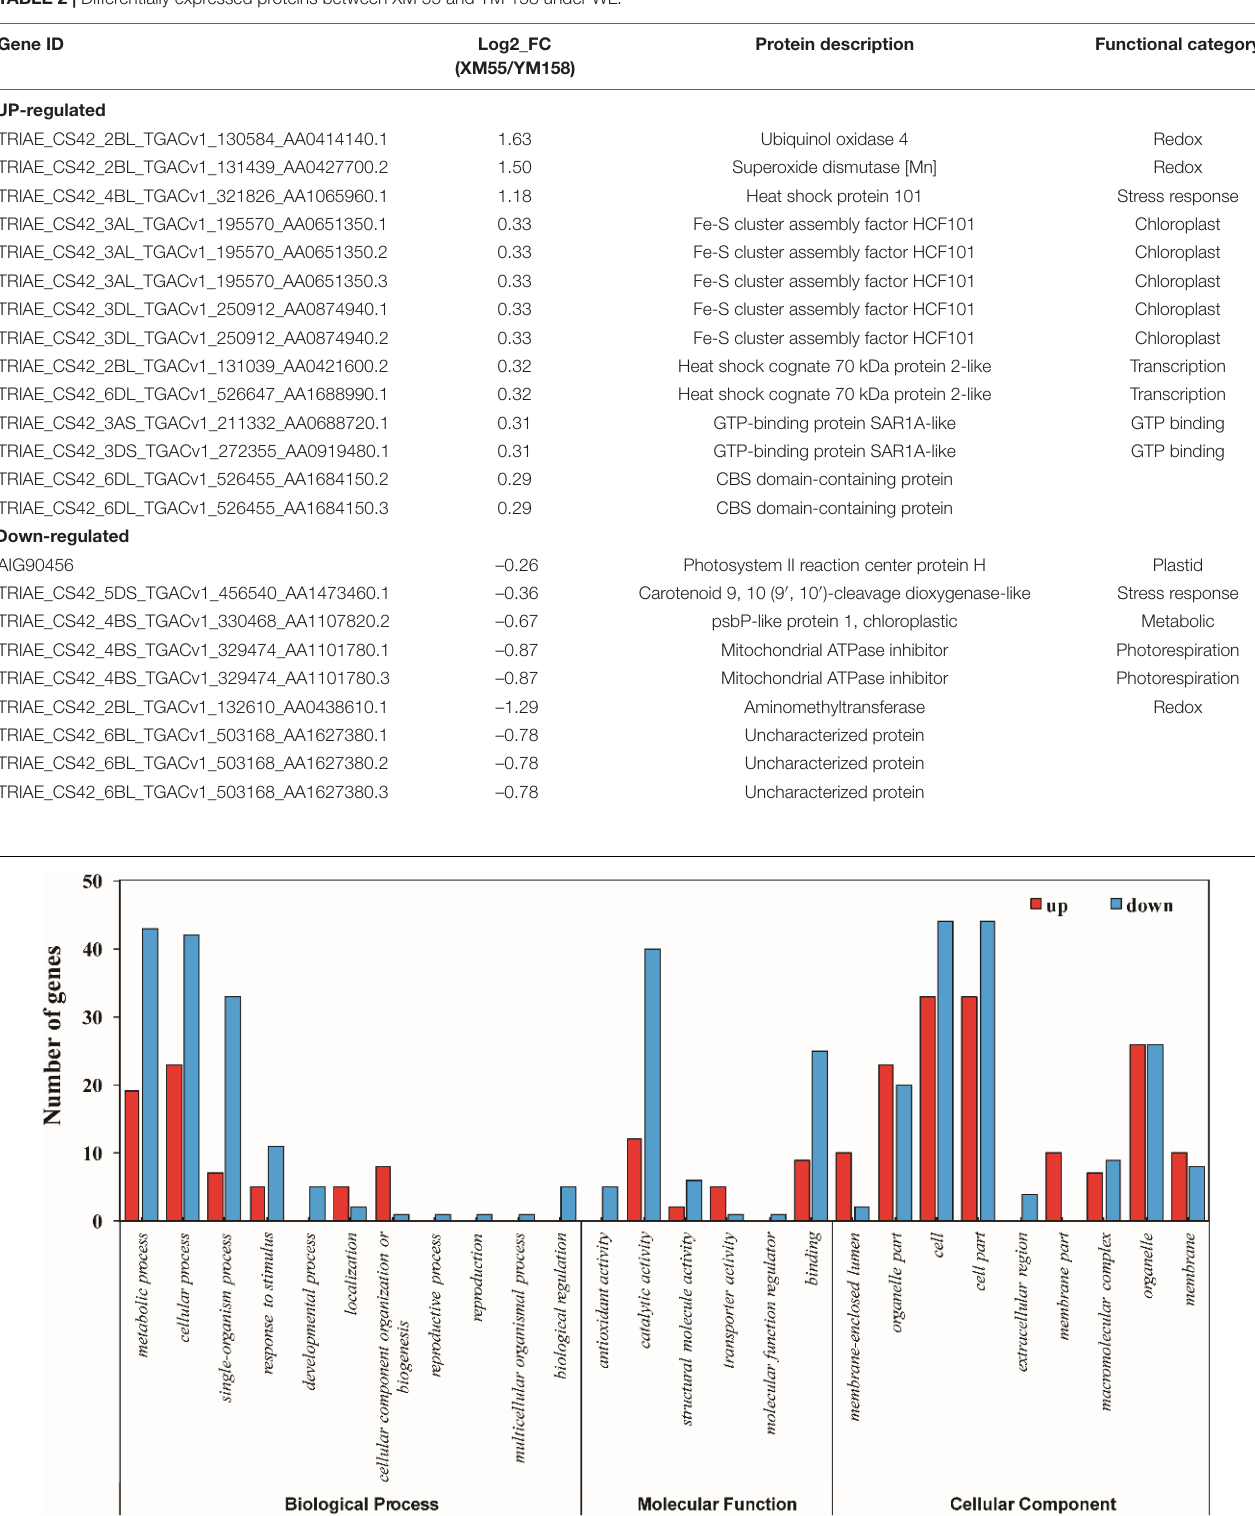
Frontiers in Plant Science |